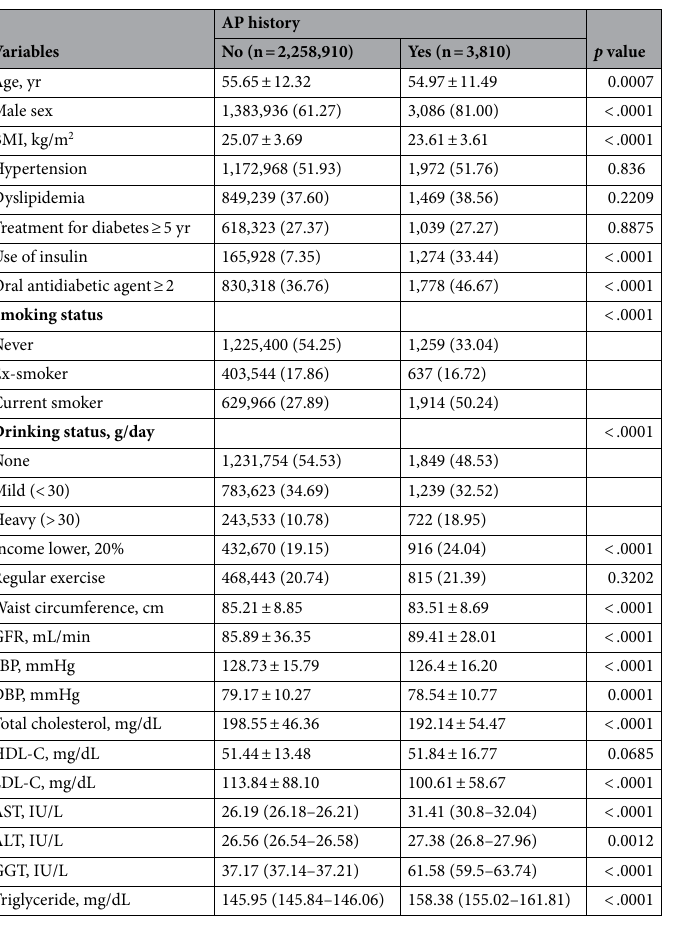
Table 1. Baseline characteristics according to acute pancreatitis history. Values are presented as number (%), mean ± standard deviation, or geometric means (95% confidence interval). AP acute pancreatitis; BMI body mass index; GFR glomerular filtration rate; SBP systolic blood pressure; DBP diastolic blood pressure; HDL-C high density lipoprotein cholesterol; LDL-C low density lipoprotein cholesterol; AST aspartate aminotransferase; ALT alanine aminotransferase; GGT gamma-glutamyl